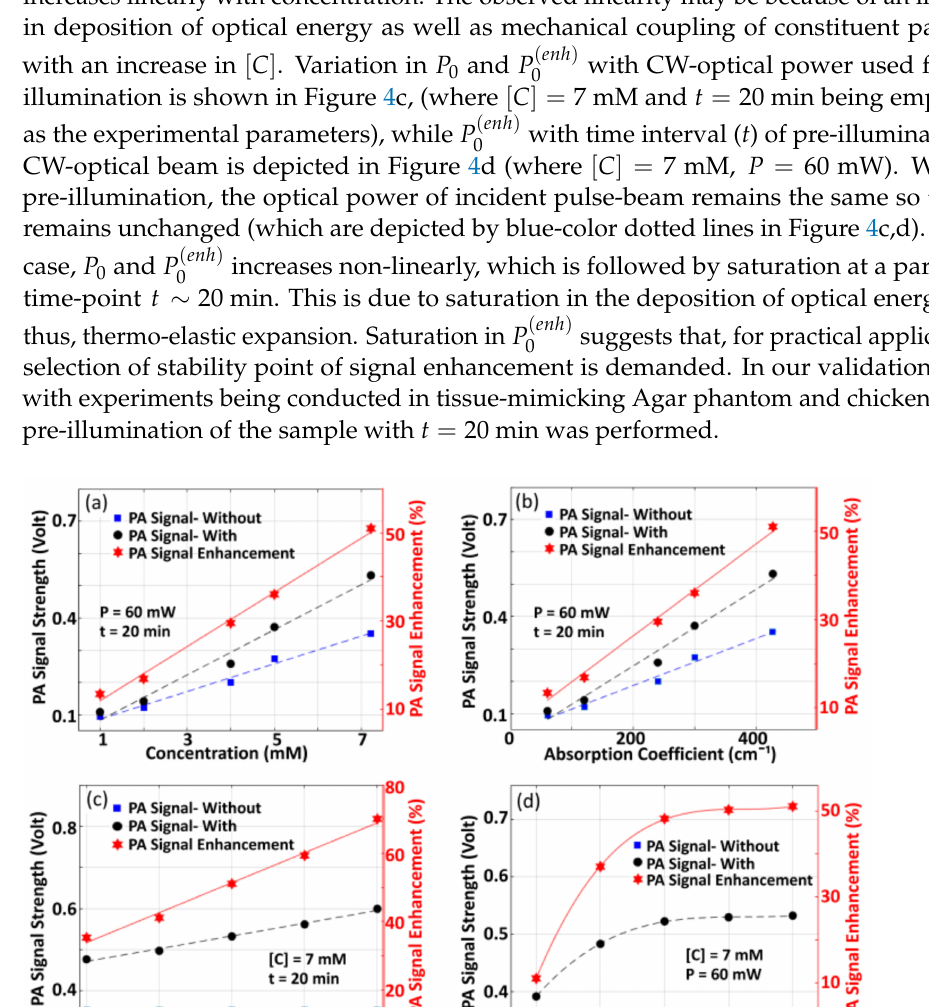
Figure 4. ( a ) Variation of measured P 0 and P experiments, we employed a continuous wave (CW)-laser of power ( P ) ∼ 60 mW and time duration of pre-illumination ( t ) ∼ 20 min). ( b ) Variation of measured P 0 and P coefficient (where P = 60 mW and t = 20 min). ( c ) Variation of measured P 0 and P power of CW-optical beam (where [ C ] = 7 mM and t = 20 min), ( d ) Variation of P 0 and P time-interval of pre-illumination (where [ C ] = 7 mM, P = 60 mW). In all of the experiments, we employed pulsed laser beam of wavelength, λ ∼ 670